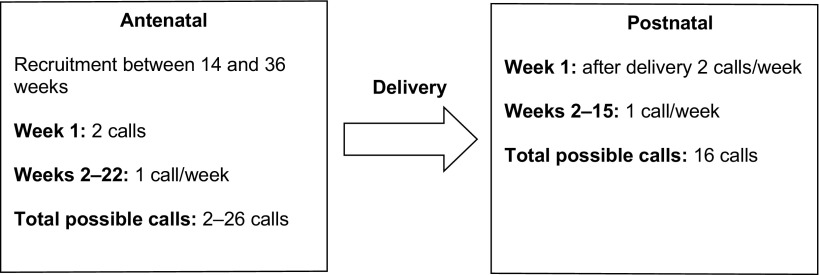
Cell Phone Counseling Protocol